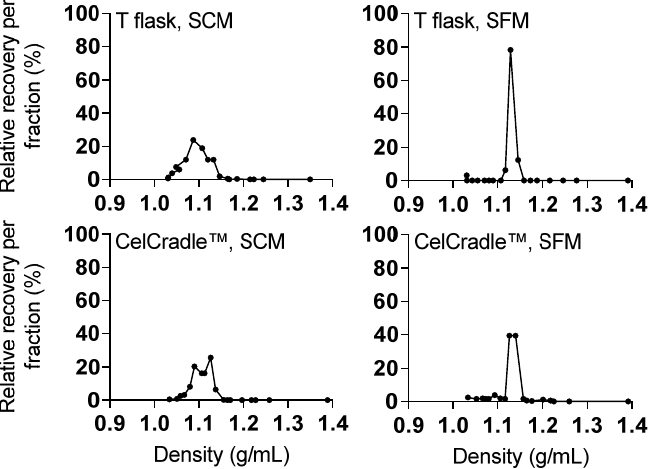
Figure 7. HCV produced in the CelCradle™ and in monolayer cultures showed similar buoyant density profiles. Buoyant density profiles were obtained for HCV produced in the CelCradle™ or T flasks under SC conditions (CC-DMEx1-SCM, Figure 1) and SF conditions (CC*-DMEx2-SFM, Figure 3) following fractionation by ultracentrifugation through a continuous 10–40% iodixanol gradient. The relative HCV recovery per fraction was calculated by relating amounts of HCV (FFU) in each fraction to the total amount of HCV in all fractions.